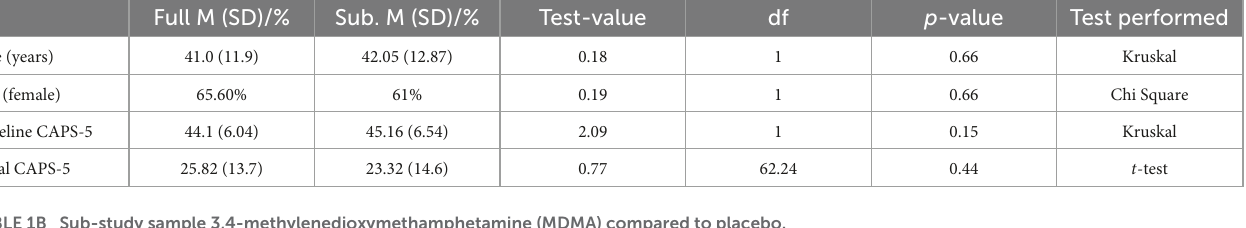
TABLE 1B Sub-study sample 3,4-methylenedioxymethamphetamine (MDMA) compared to placebo.